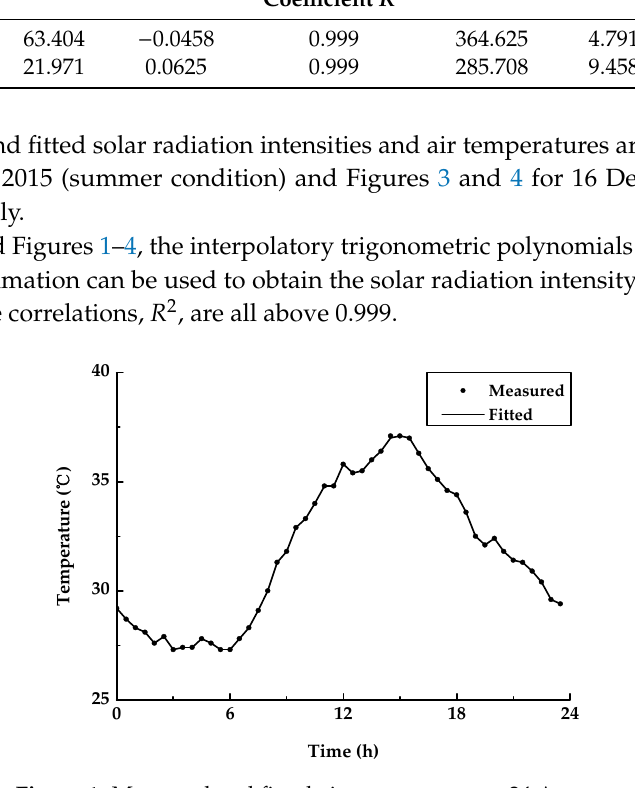
Figure 2. Measured and fitted solar radiation intensity on 24 August.